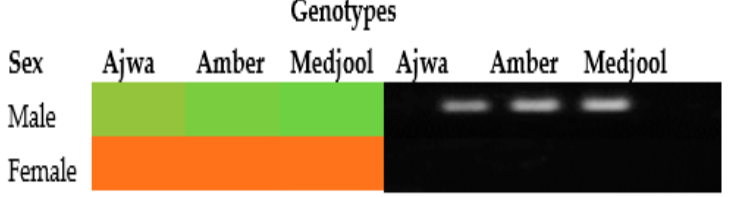
Figure 2. TPD1-like ampli fi cation in the leaves using date palm sucker cDNA as a template. PCR product was run on 1.5% agarose gel using a 100 bp ladder (Thermo Scienti fi c Inc., Waltham, MA, USA). The heat map indicated the expression intensity: green for high expression, light green for low expression and orange for no expression.